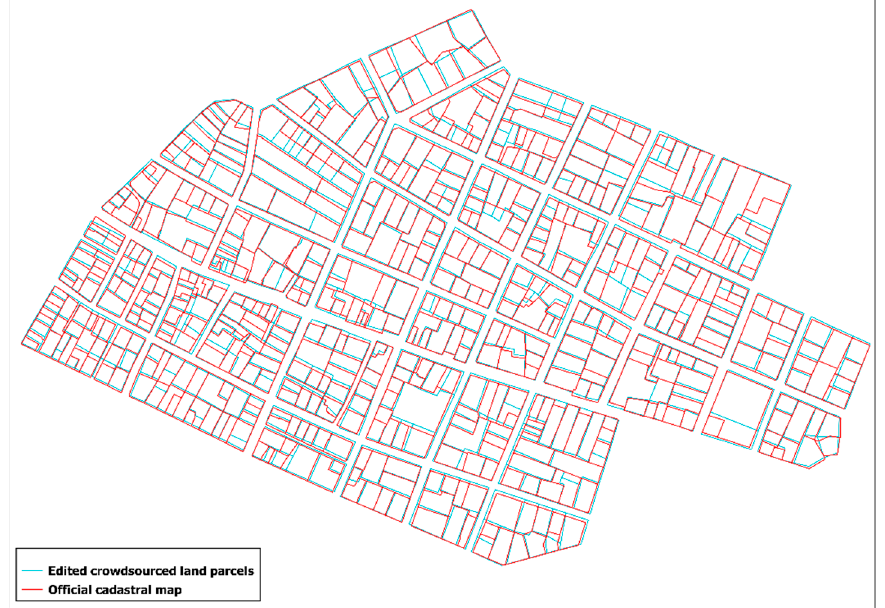
Figure 26. Comparison of the edited crowdsourced cadastral map (in red) with the official map (in blue). Figure 27 shows the edited advanced crowdsourced cadastral basemap. Editing duration is 3 h.